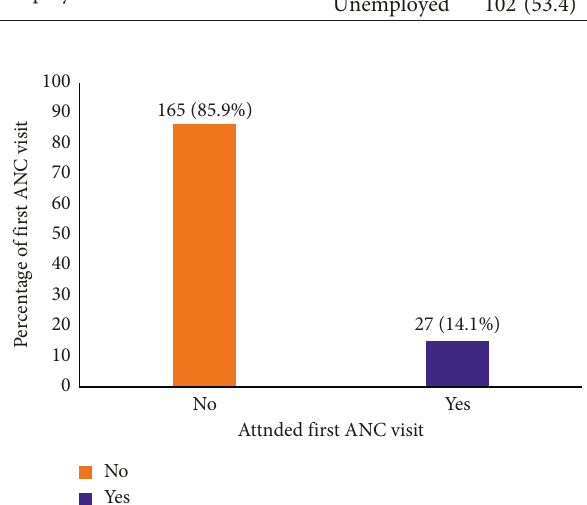
Figure 1: Bar graph showing participant attendance of first ANC visit. Bivariate analysis of socio-demographic factors and timely attendance of the